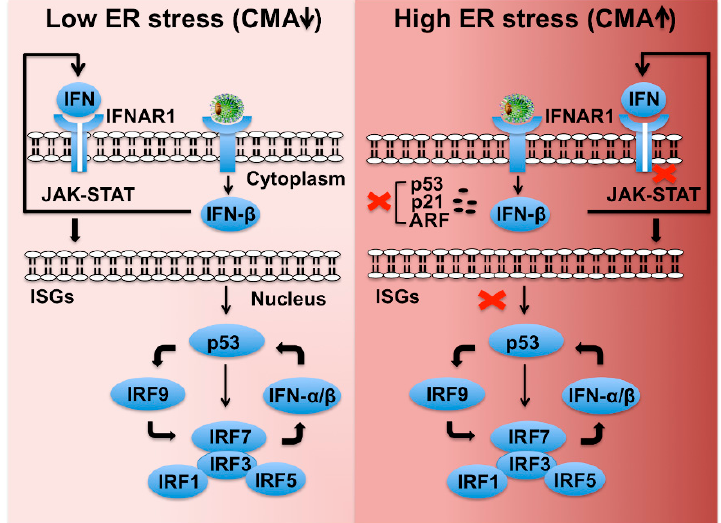
Figure 8. Shown is a hypothetical model demonstrating how HCV-induced severe stress response impairs IFNAR1-p53-mediated innate antiviral loop that blocks transcription of type I IFN, ISGs, and IRFs. Low stress favors cellular p53-mediated cellular expression of ISGs and various IRFs that maintain the innate hepatic immunity and cellular apoptosis. Hepatic adaptive response to virus-associated stress selectively promotes CMA-associated degradation of IFNAR1, p53, and p14ARF and favors cell survival. Loss of IFNAR1 and p53 disables the activation of the innate feedback loop leading to severe impairment of innate immunity in the highly stressed cirrhotic liver.